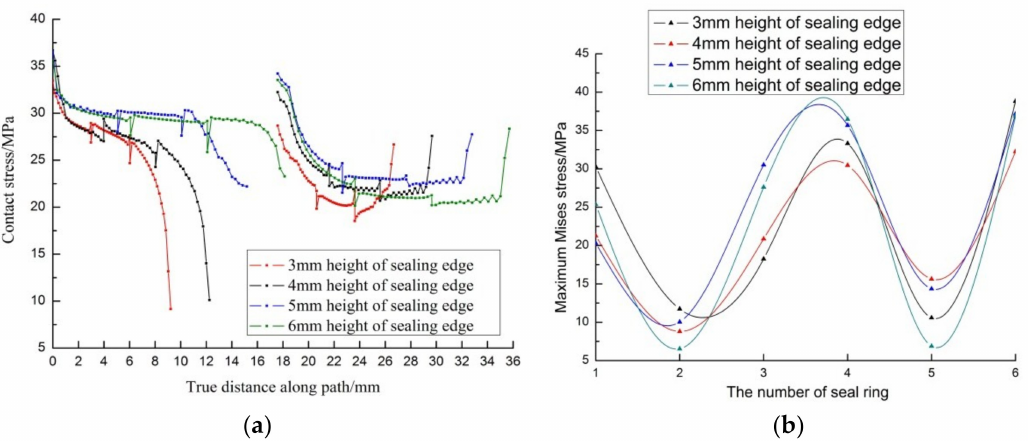
Figure 8. The stress distribution curve of sealing ring under different heights of sealing edge: ( a ) contact stress distribution curve; ( b ) Mises stress distribution